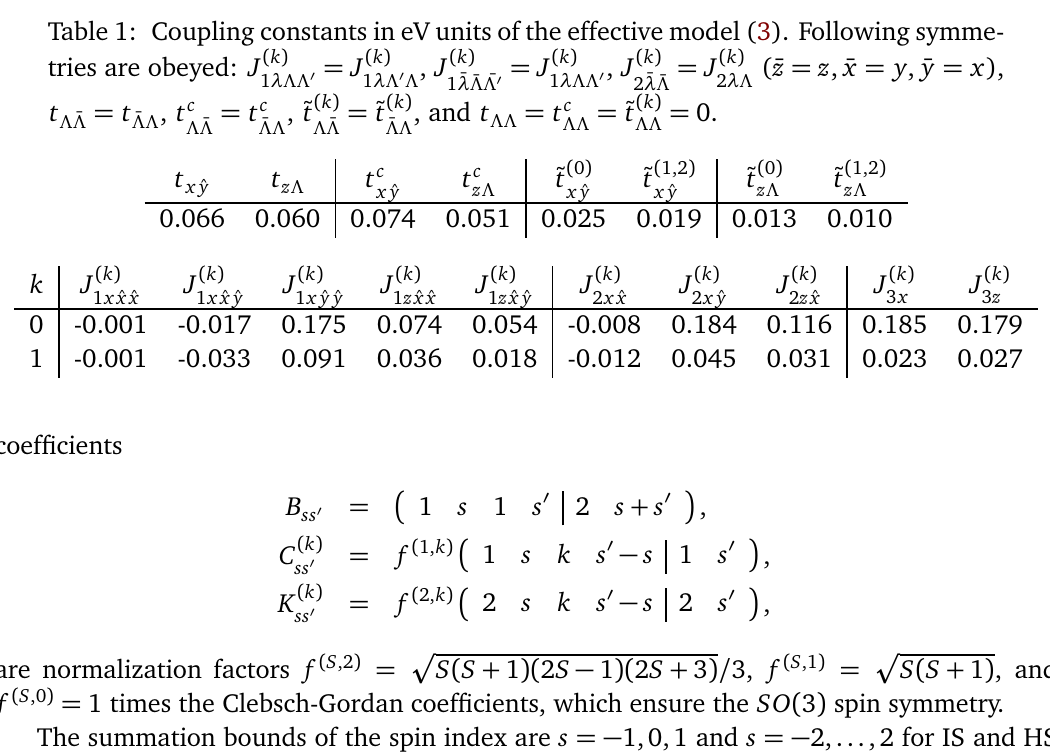
( k ) ( k ) ( k ) = J ( k ) = J ( k ) = J ( k ) (¯ z = z , ¯ x = y , ¯ y = x , J , J 2¯ λ ¯ Λ 1¯ λ ¯ Λ ¯ Λ (cid:48) 2 λ Λ 1 λ ΛΛ (cid:48) 1 λ ΛΛ (cid:48) 1 λ Λ (cid:48) Λ